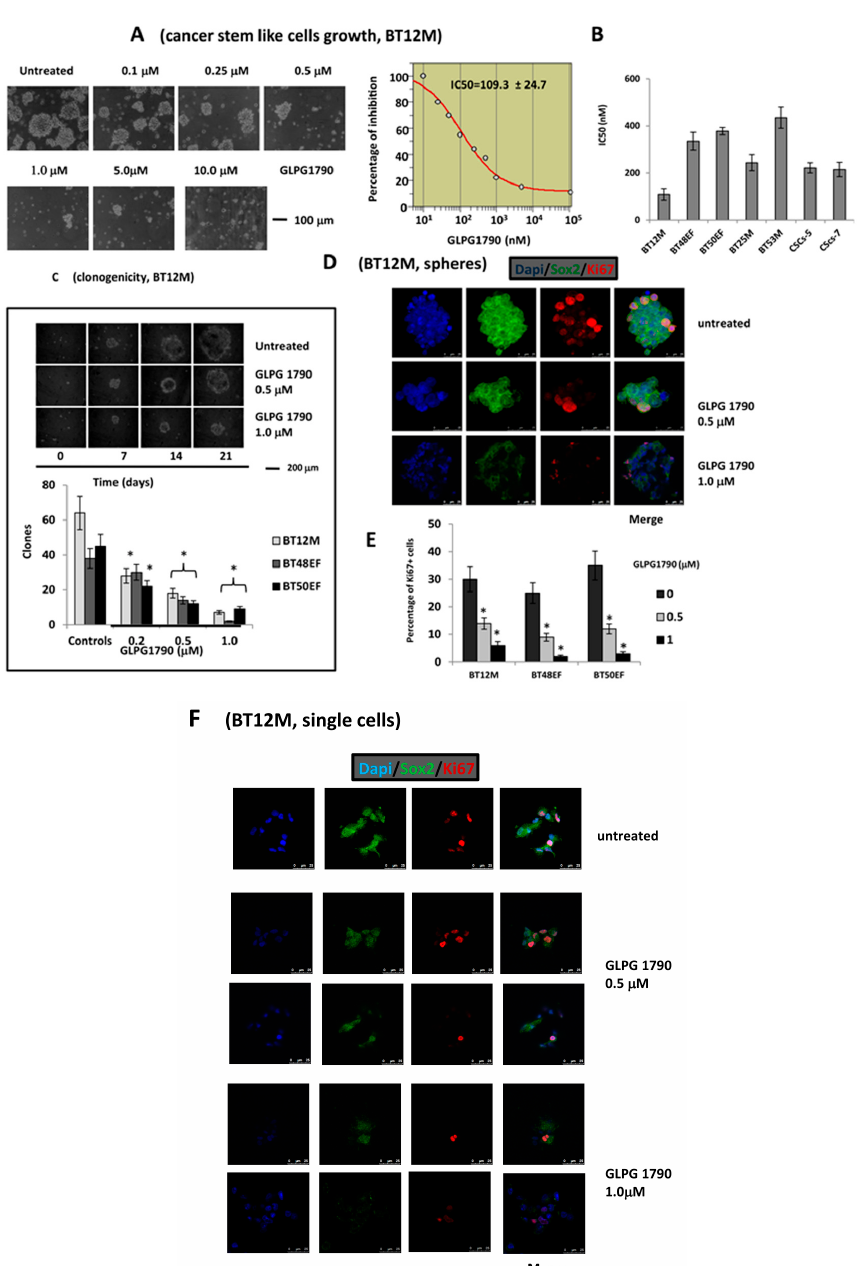
Figure 2. Proliferation of glioma stem cells cultured with different doses of GLPG1790. ( A ) Growth changes of BT12M CSCs; GLPG1790 reduced the number and size of BT12M cells. ( B ) IC50 values calculated for singles GIC cultures. ( C ) GLPG1790 reduced the sphere generation dose-dependently in clonogenic assays in BT12M, BT48EF and BT50EF cells. ( D ) Reduced Ki67 expression after the GLPG1790 treatment, both as a protein amount and percentage of positive cells; the reduction was dose-dependent in the BT48EF culture. Scale bar: 25 µ m. ( E ) Dual Sox2 and Ki67 determination in single cells or in very small cell aggregates from treated and untreated cultures. ( F ) Dual Sox2/ki67 determination in single cells. Scale bar: 25 µ m. Data are representative of three similar results performed in triplicate. Confocal images were collected and shown as maximal projection of about 20 analysed spheres observed with 0.29- µ m size serial sections. * p <